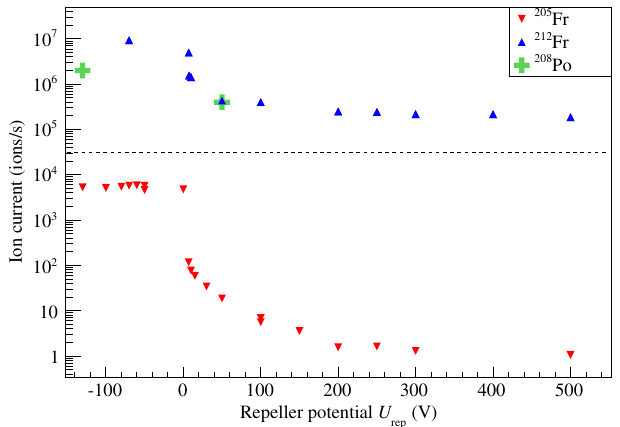
FIG. 5. Effect of the repeller potential on the ion current of laser-ionized polonium and surface-ionized francium isotopes. Negative voltages correspond to the ion-guide mode, while positive voltages correspond to the LIST mode. Data taken with different techniques are normalized to ions per second, and the detection limit for the Faraday-cup measurements is shown with the dotted